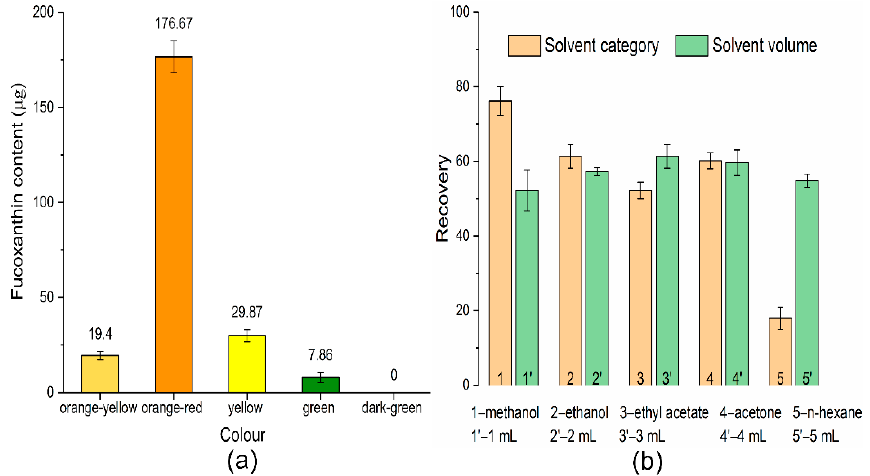
Figure 3. Fucoxanthin content in different colour bands ( a ), elution solvent and volume on the recovery rate of HLB solid-phase extraction column ( b ).